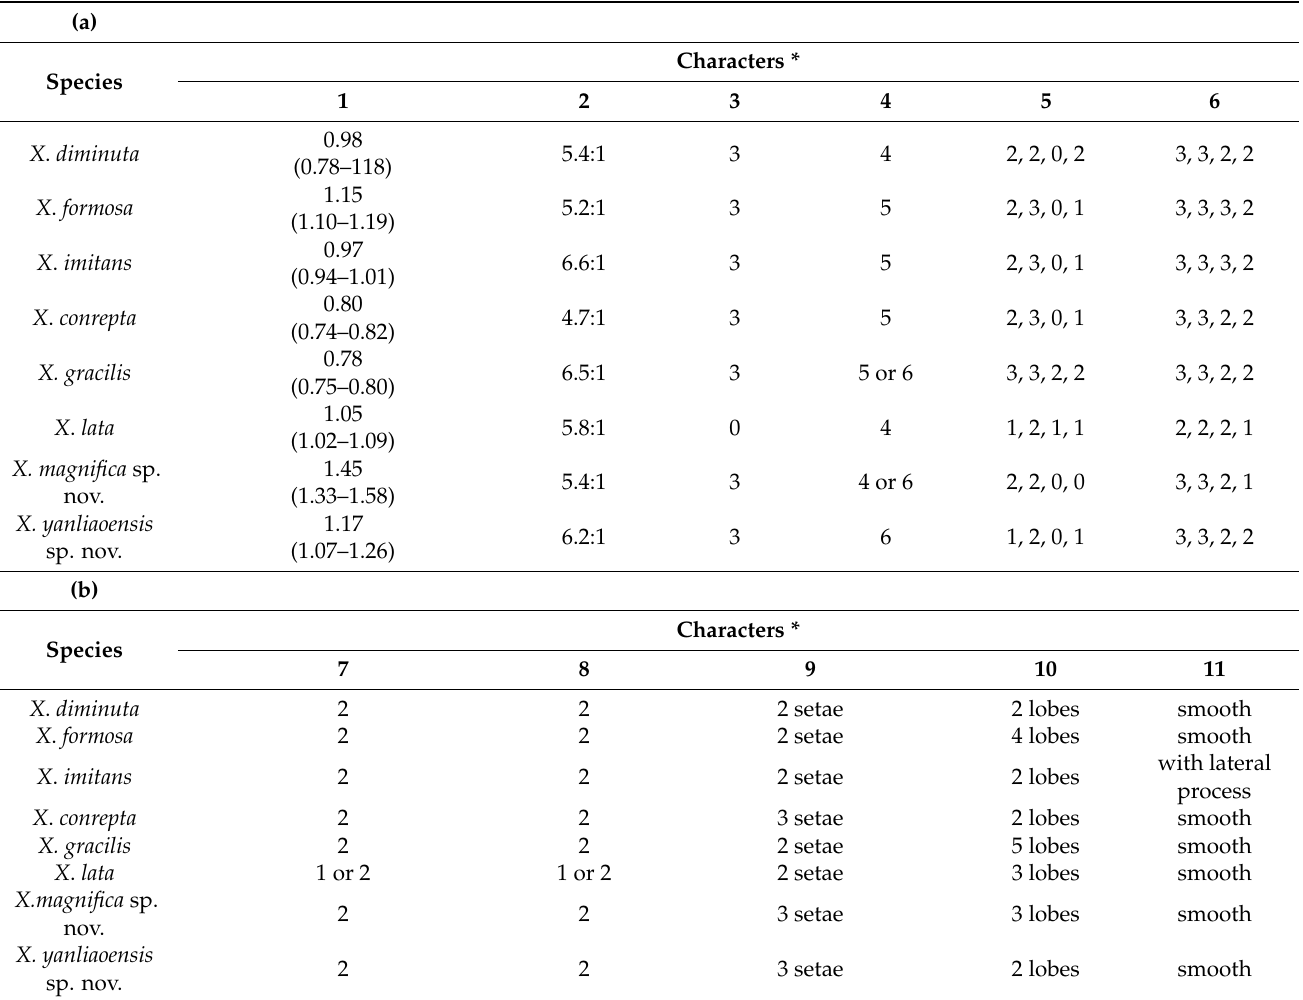
Table 2. Differences between the eight species of Xarifia copepods isolated from Psammocora